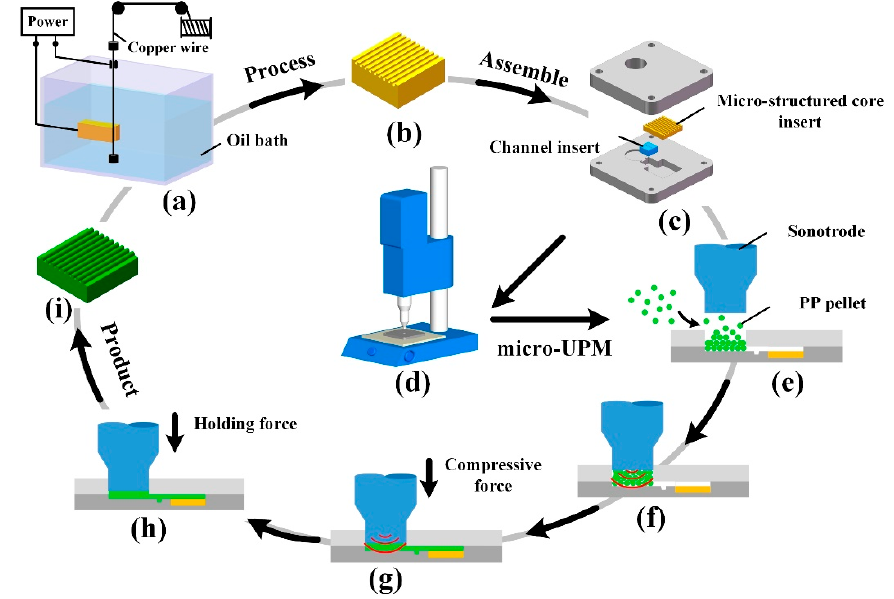
Figure 3. Schematic diagram of the preparation process of the micro-structured parts: ( a ) processing the core insert by the low speed wire electrical discharge machining (WEDM-LS); ( b ) micro-structured core insert; ( c ) assembling the combined mold; ( d ) ultrasonic welder; ( e ) filling with Polypropylene (PP) pellets; ( f ) turning on ultrasonic vibration; ( g ) filling of PP melt into the mold cavity; ( h ) holding state; ( i ) micro-structured part.